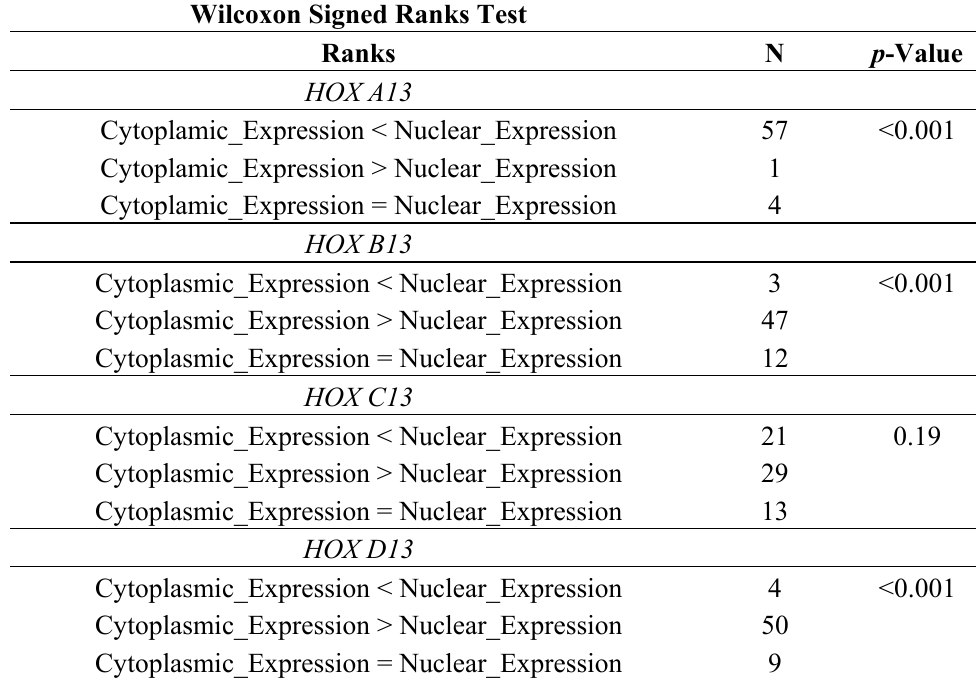
Table 2. Cytoplasmic versus nuclear expression distribution of HOX A13 , HOX B13 , HOX C13 and HOX D13 . Wilcoxon Signed Ranks